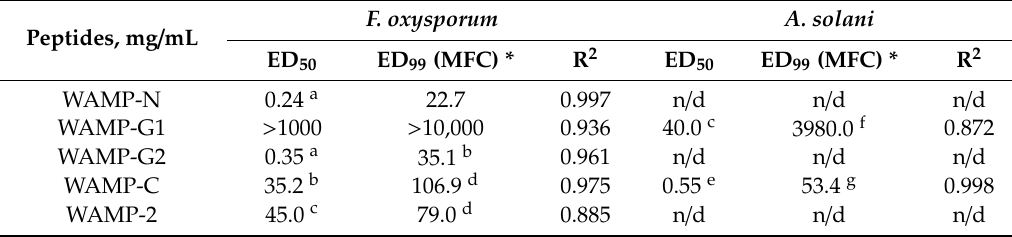
Table 1. E ff ective doses (ED) of the synthesized WAMP-2-derived